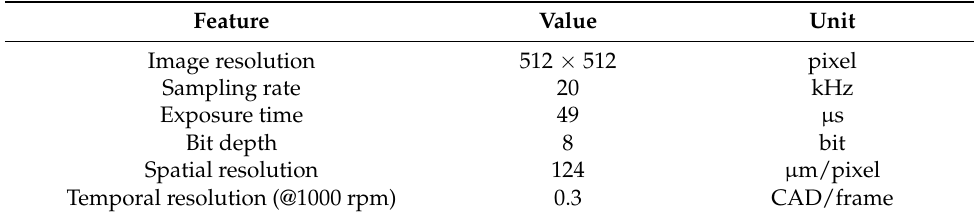
Table 1. High-speed camera